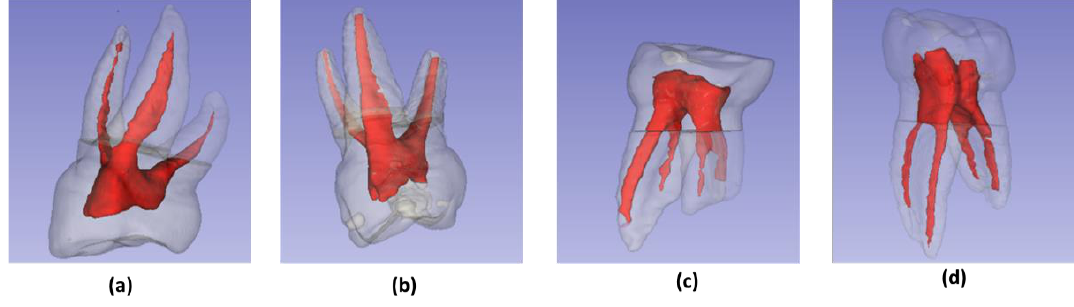
Figure 2. Three-dimensional reconstructions: ( a ) Maxillary 1st molar; ( b ) Maxillary 2nd molar; ( c ) Mandibular 1st molar; ( d ) Mandibular 2nd molar.